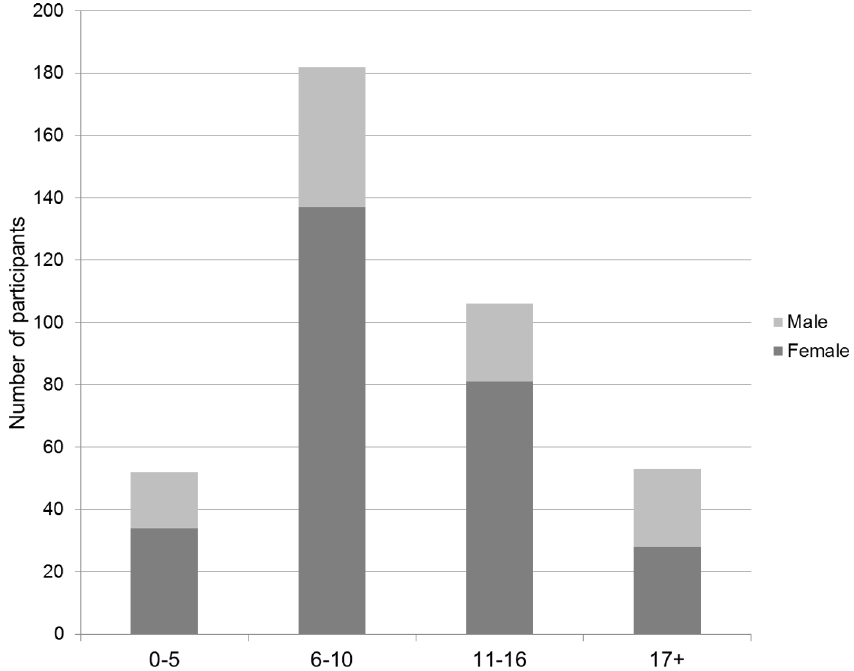
Figure 3. Age-sex classes distribution. doi:10.1371/journal.pone.0099874.g003 PLOS ONE |